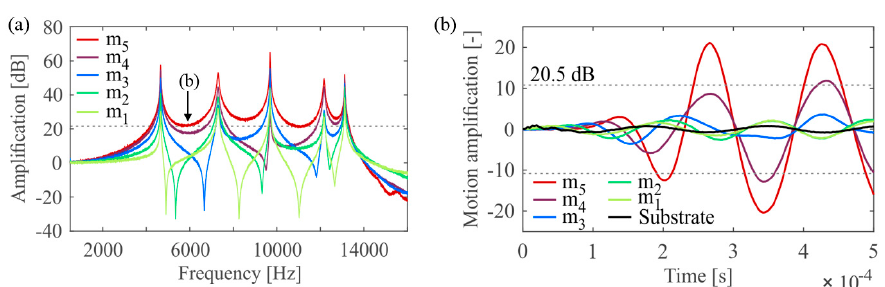
Figure 5. ( a ) Transfer functions of masses of device N5. Expected anti-resonances can be observed for m 1 to m 4 ; ( b ) Dynamic off-resonant response of N5 at 5845 Hz, between first and second Eigenmode. Wave travels from the substrate towards the center mass m 5 and is amplified. Baseline amplification is reached approx. within 0.2 m 5